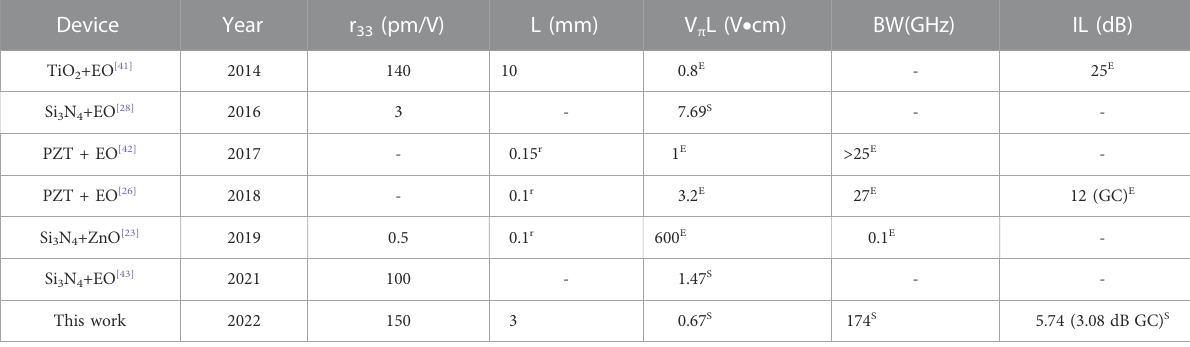
TABLE 4 The performance comparison of modulators with different structures.